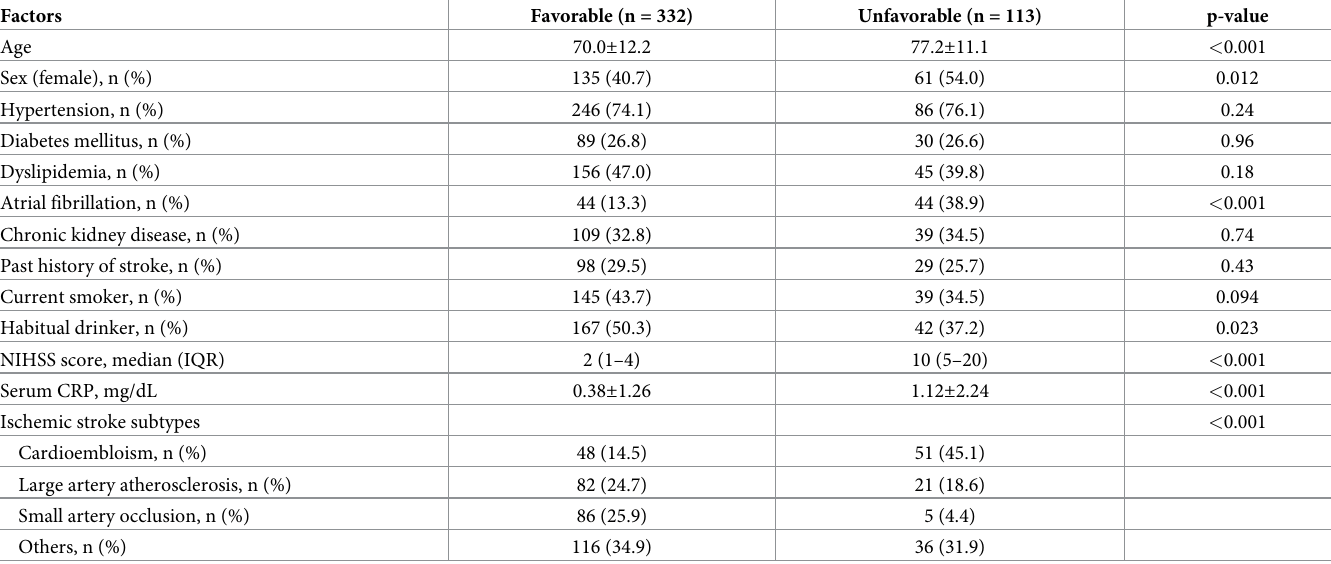
Table 2. Univariate analysis of baseline characteristics to determine associations with unfavorable outcome.